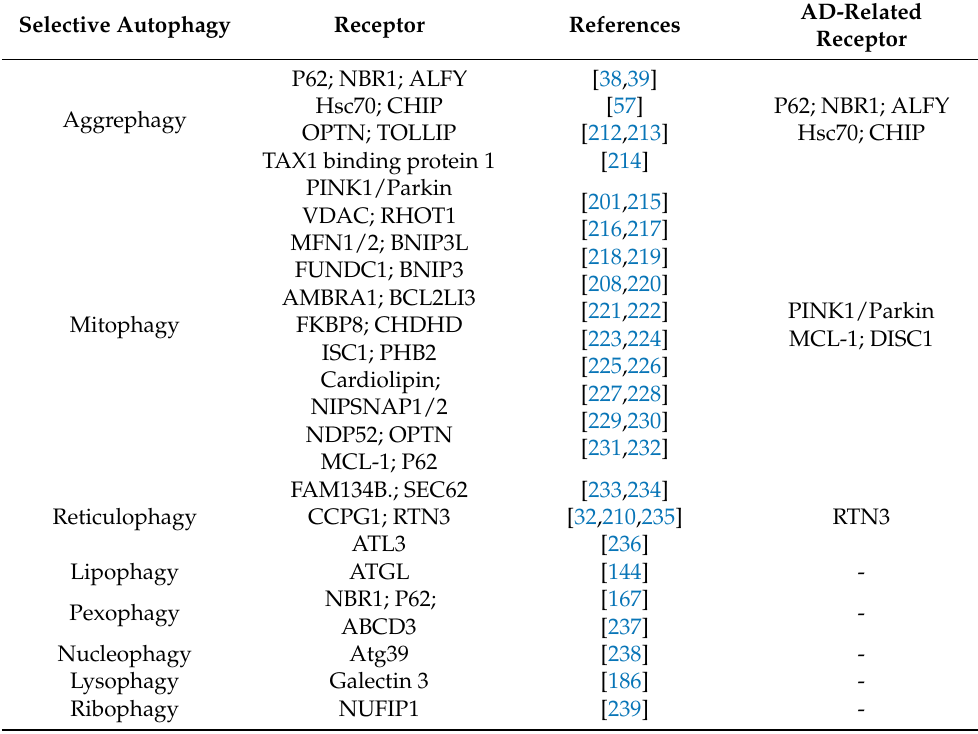
Table 1. List of selective autophagy receptors in the pathogenesis of